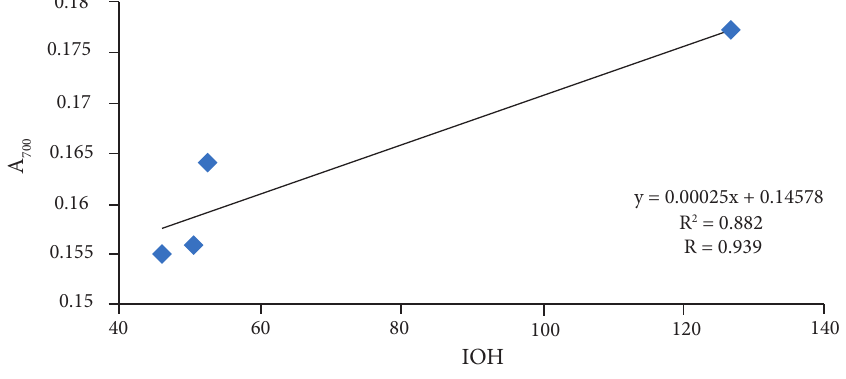
Figure 8. FT-NIRA calibration curve for IOH determination in surfactants – A versus IOH (measured by wet chemistry method). 7000 Figure 8. NIRA calibration curve for IOH determination in surfactants – A 7000 versus IOH (measured by wet chemistry method). IOH = Hydroxyl number; NIRA = Near infrared reflection